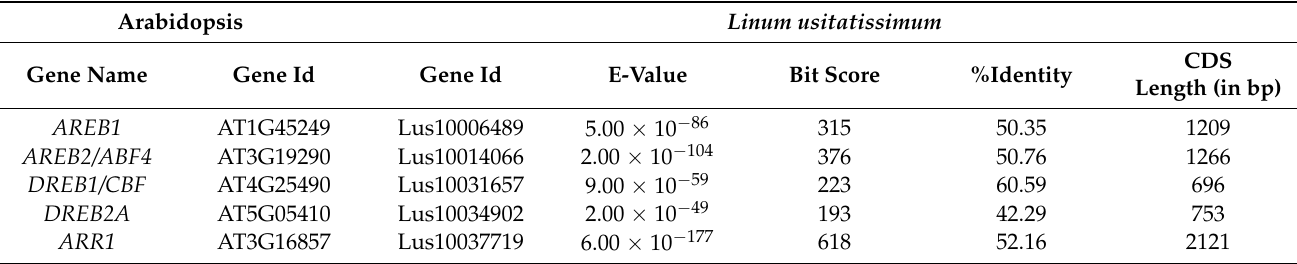
Table 1. Drought-responsive gene orthologs AREB1 , AREB2/ABF4 , DREB1/CBF , DREB2A , and ARR1 in flax with their gene ID, E-value, and % identity taking Arabidopsis as